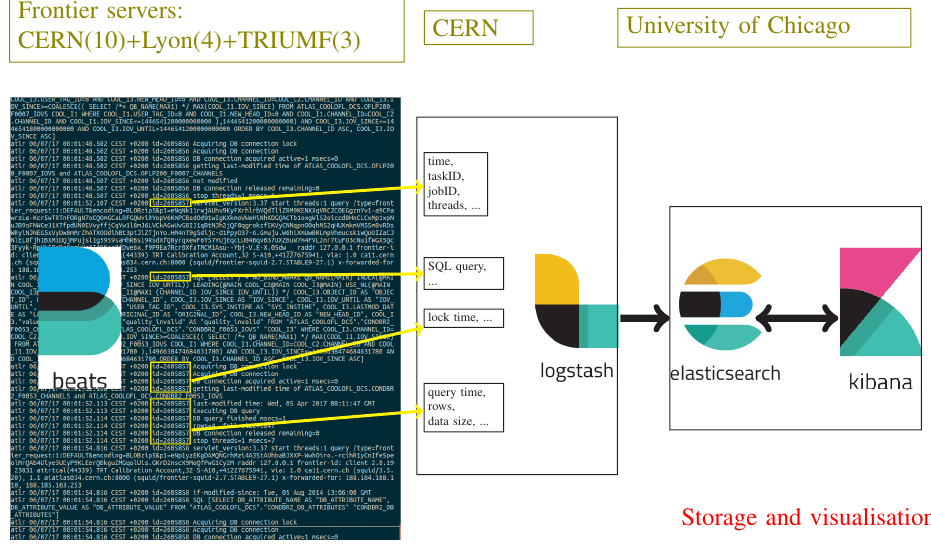
Figure 1. Schema of ELK-based Frontier